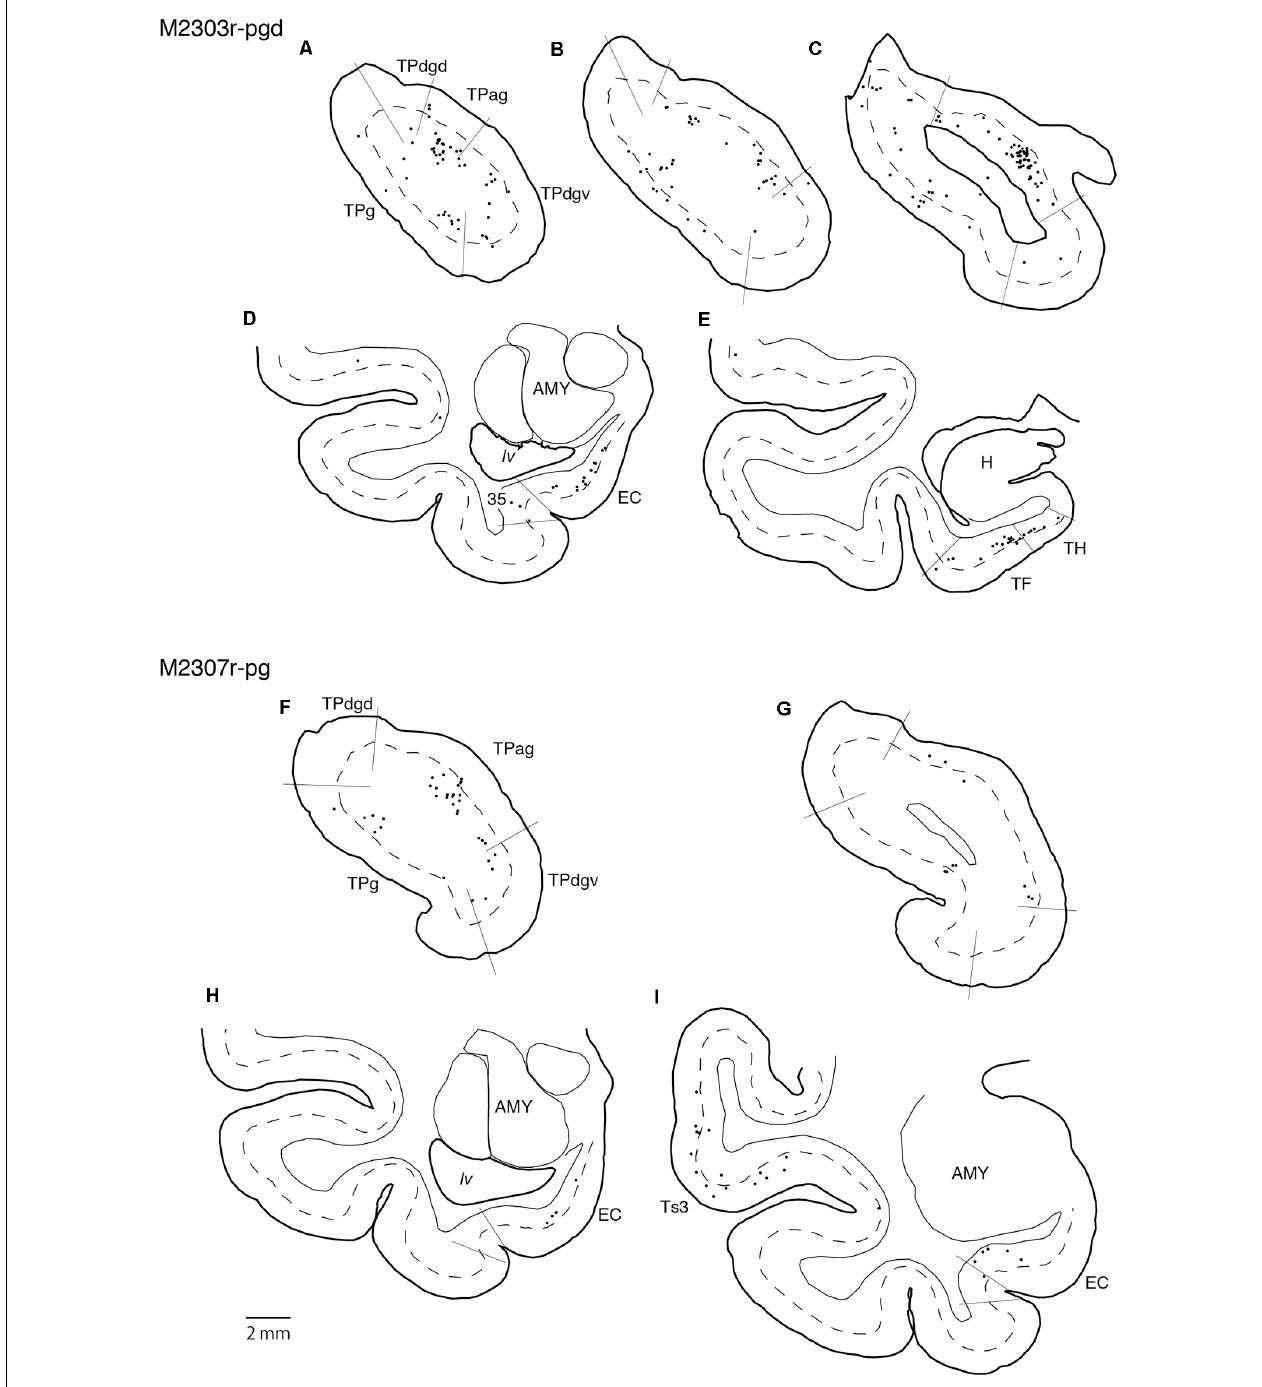
FIGURE 8 | Distribution of the labeled neurons in the TP and medial temporal cortex after injections into the pgACC (cases M2303r-pgd and M2307r-pg). (A–C,F,G) Sections through the TP. (D,E,H,I) Sections through the medial temporal cortex. 35, area 35 of perirhinal cortex; AMY, amygdala; EC, entorhinal cortex; H, hippocampus; lv, lateral ventricle; TE, area TE; TF, area TF; TH, area TH. Other conventions are as shown in Figure 4 .